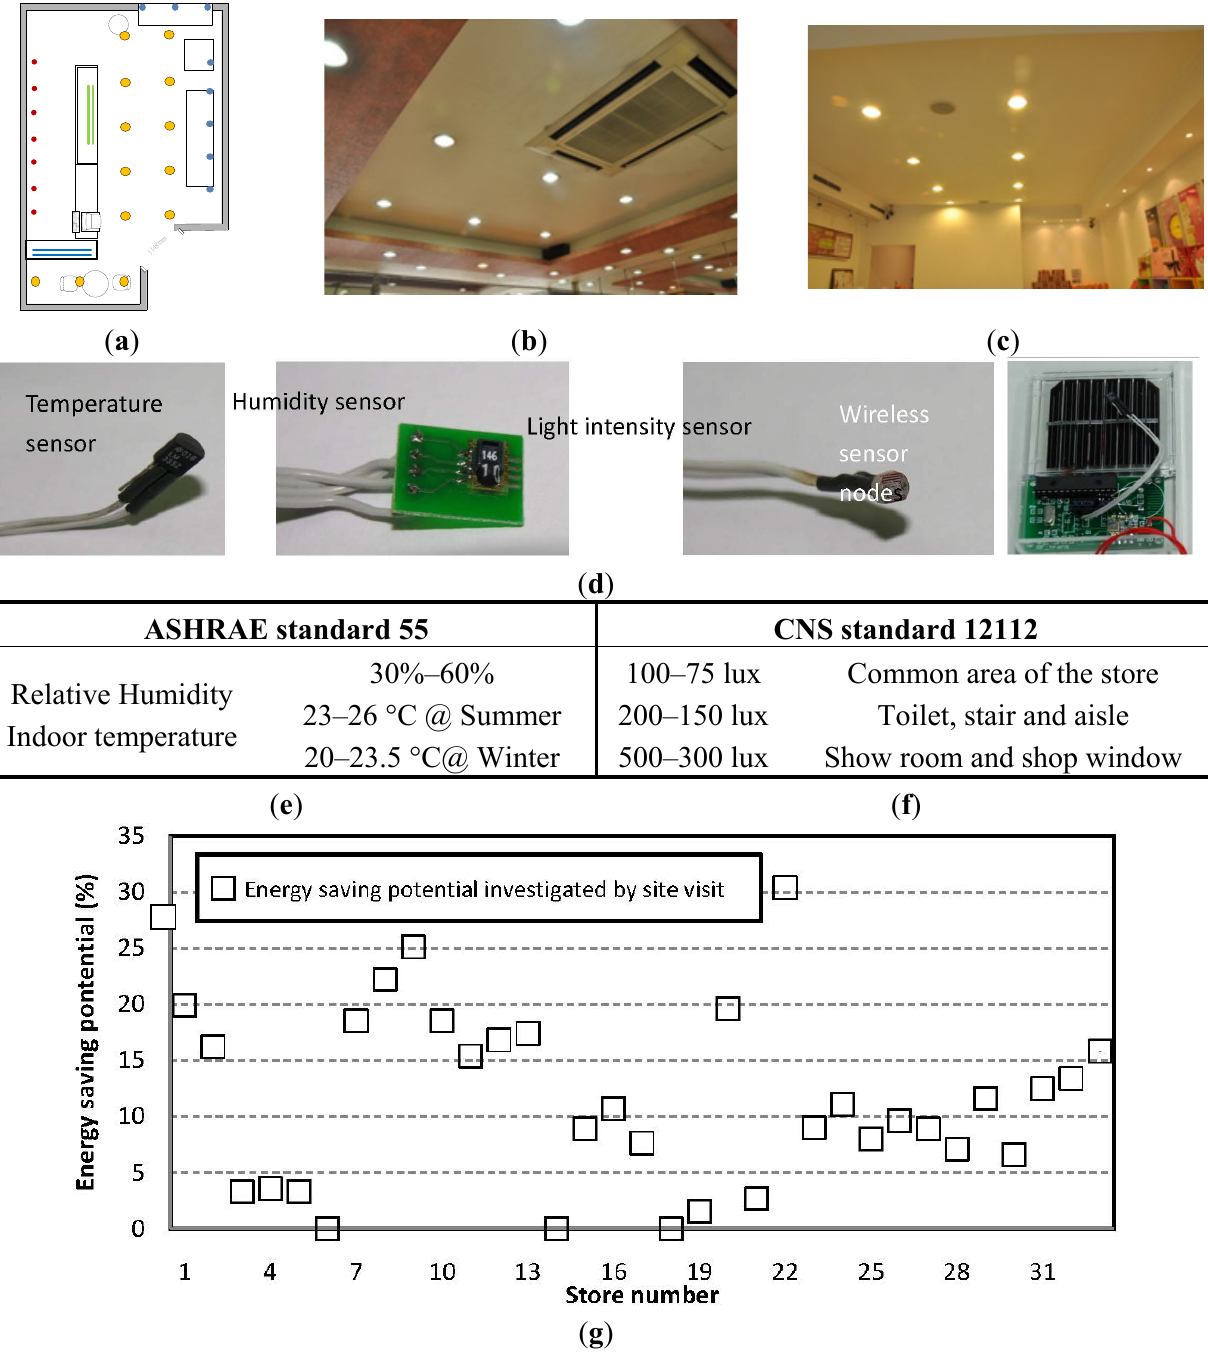
Figure 10. Site visit to investigate energy saving potential of store: ( a ) Plot floor plan and check equipment includes; ( b ) air conditioner; ( c ) lighting system; Using sensors and wireless nodes to survey environment ( d ); Adjust air conditioning setting and light intensity according to ASHRAE standard ( e ) and CNS standard ( f ); Get energy saving potential of each store ( g